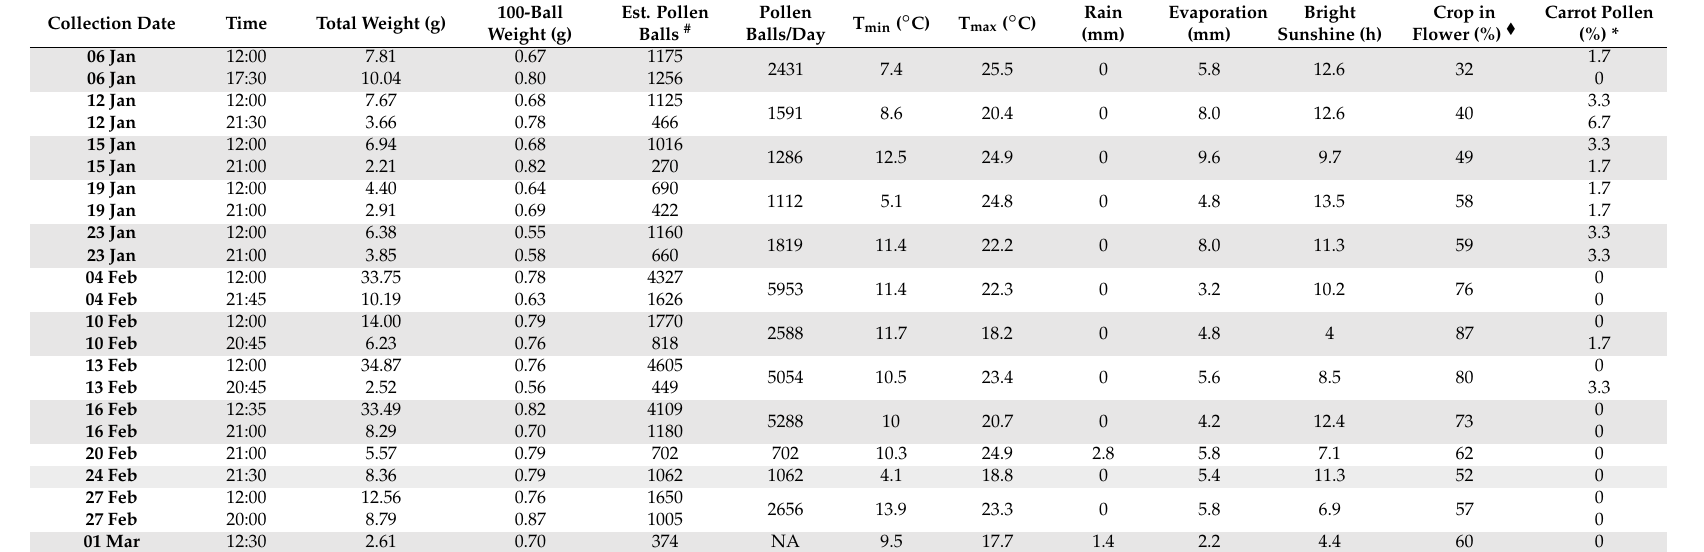
# Pollen ball numbers were estimated by weighing 100 balls from each sample. (cid:7) Percentage of crop in full bloom was calculated by counting the number of receptive umbels in a 100-umbel sample. * Carrot pollen percentage indicates the number of pollen balls containing carrot